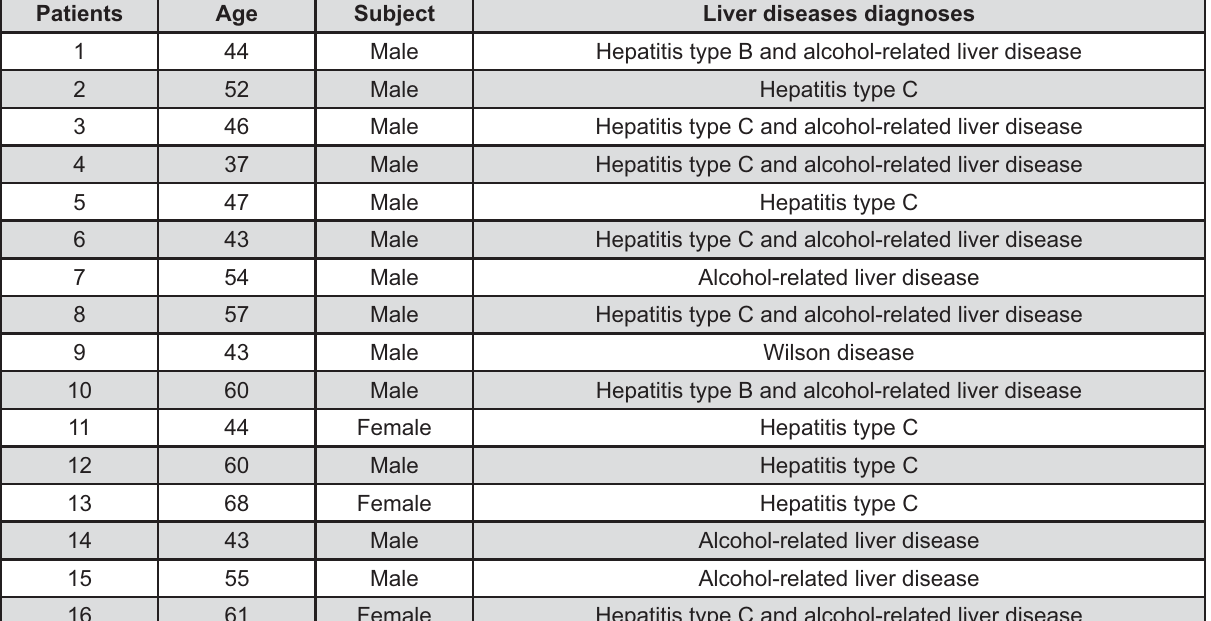
Figure 2- Characteristics of the liver transplant candidates